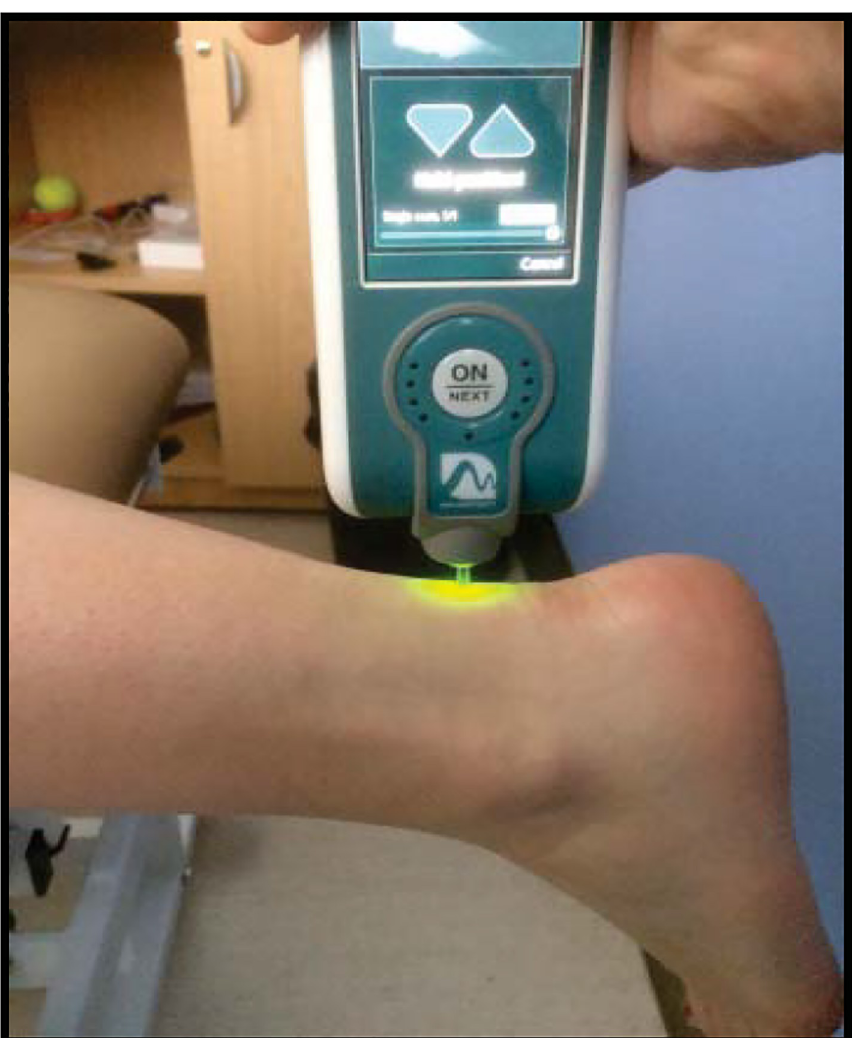
Fig 1. Testing position for transverse Achilles tendon stiffness